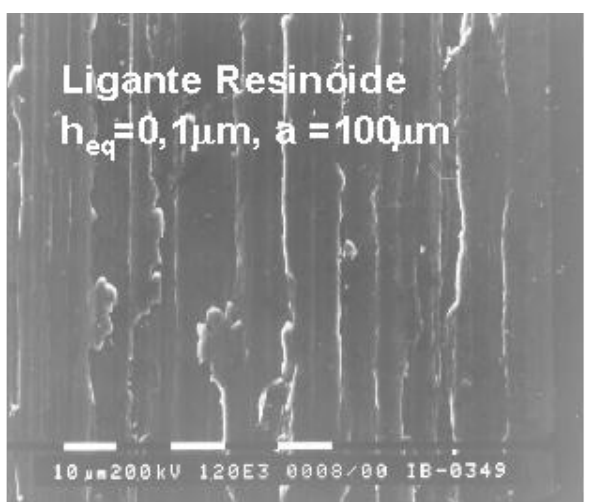
Figura 1. Ensaio 1.